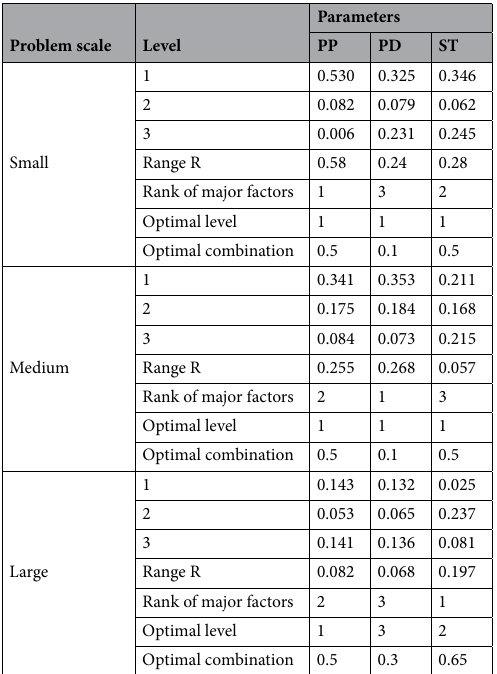
Table 5. Analysis results of Taguchi’s experiments for IMOSSA parameter settings.